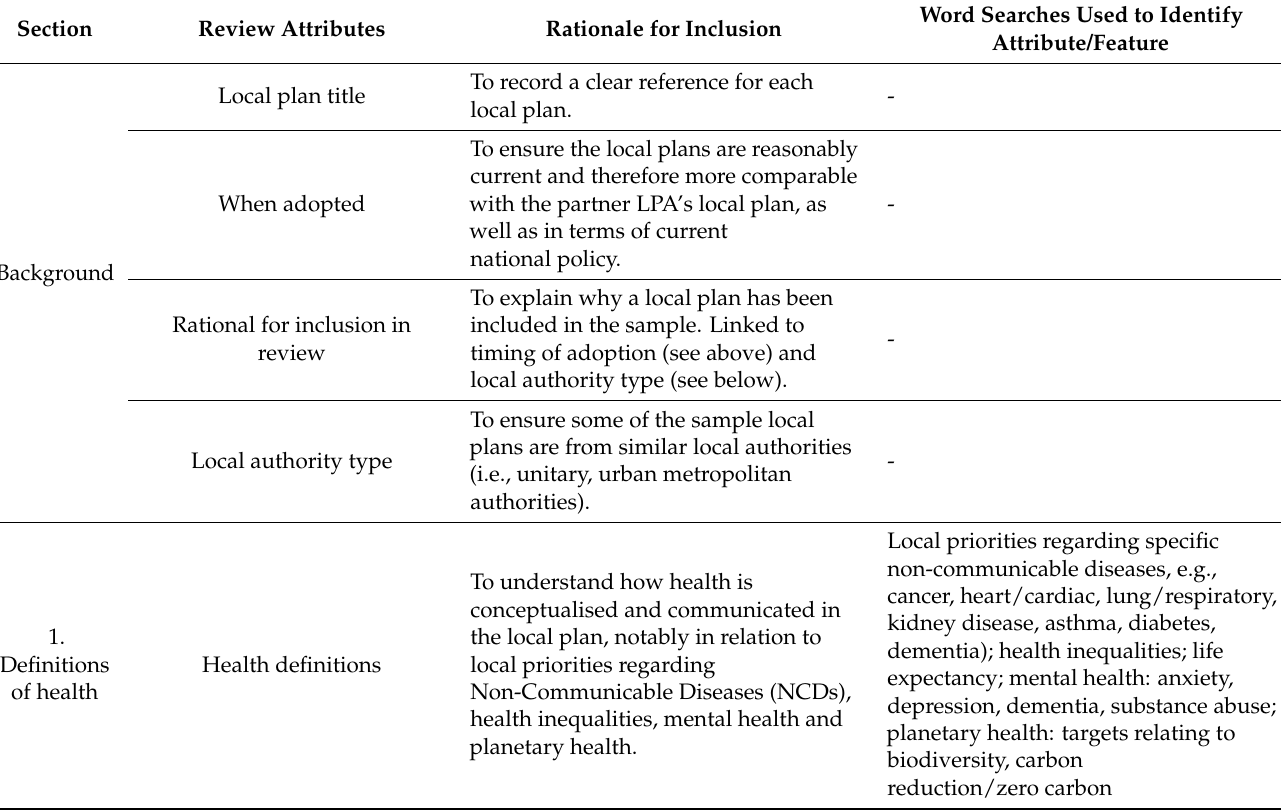
Table A1. Attributes of the Health in Local Plan review framework, rationale for inclusion and word search